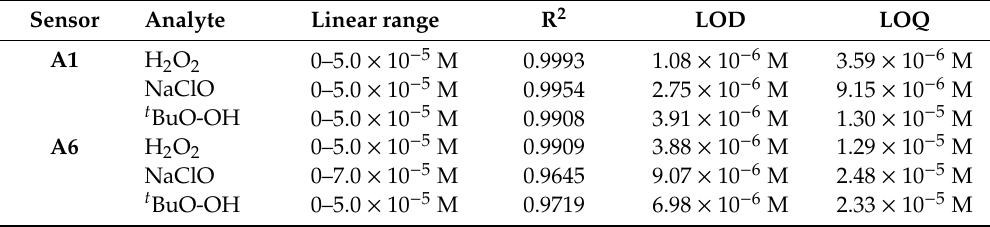
Table 2. Analytical sensitivity of the analytical reaction studied in acetonitrile.